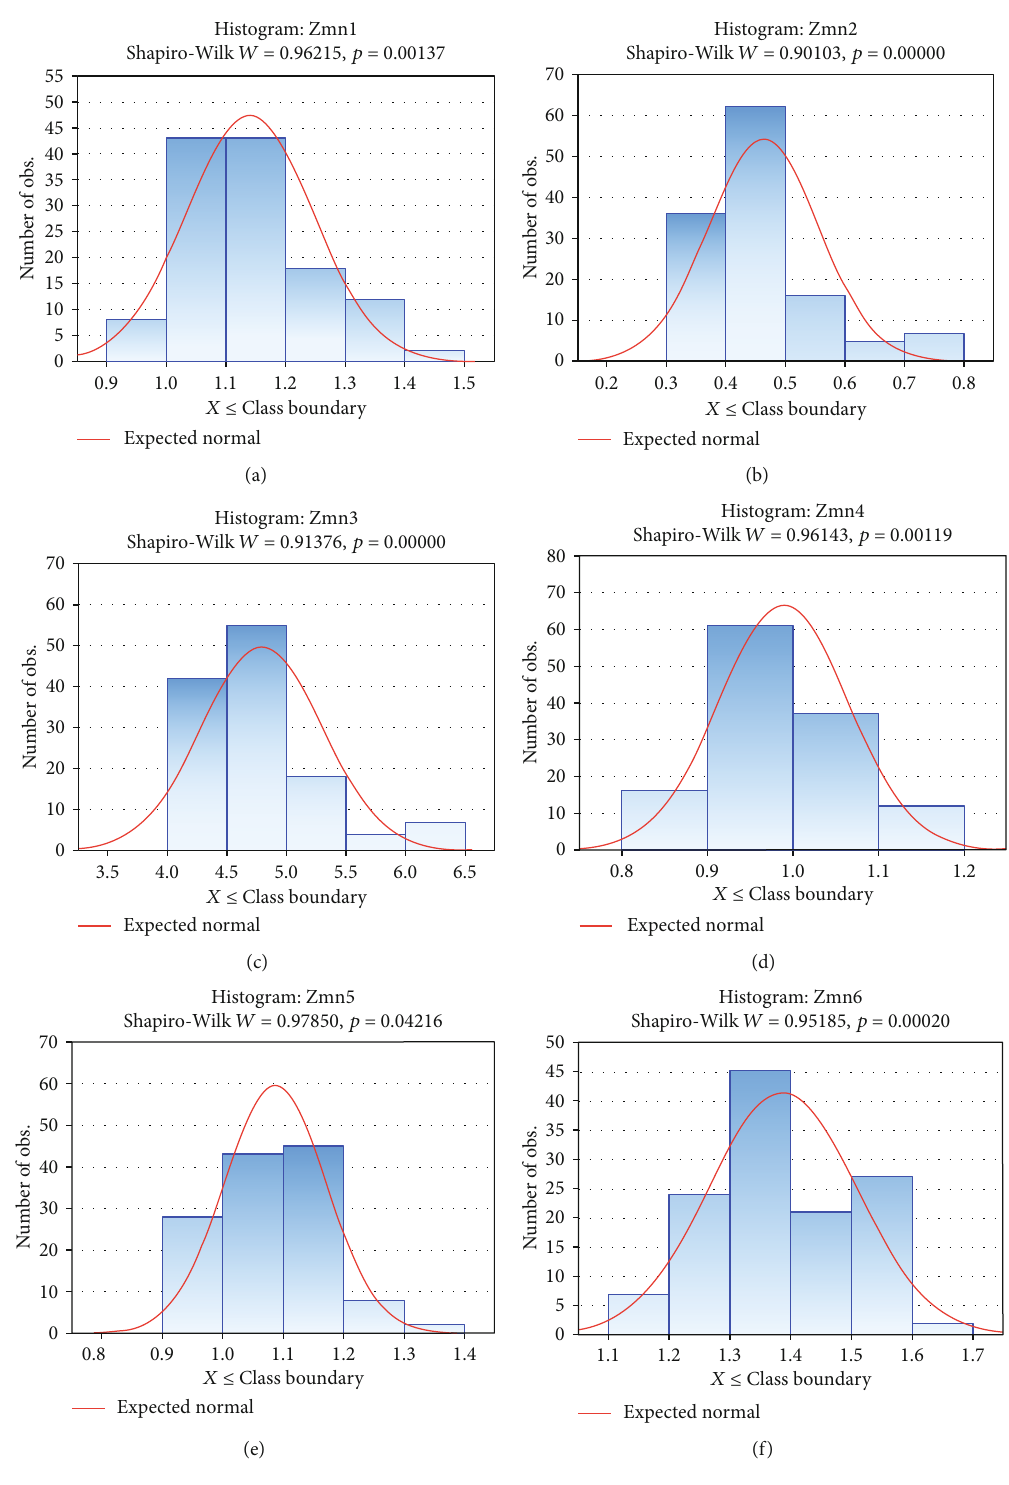
Figure 12: (a – f) The results of the Shapiro-Wilk test of decomposition normality. Table 8 presents the results obtained for the speci fi ed